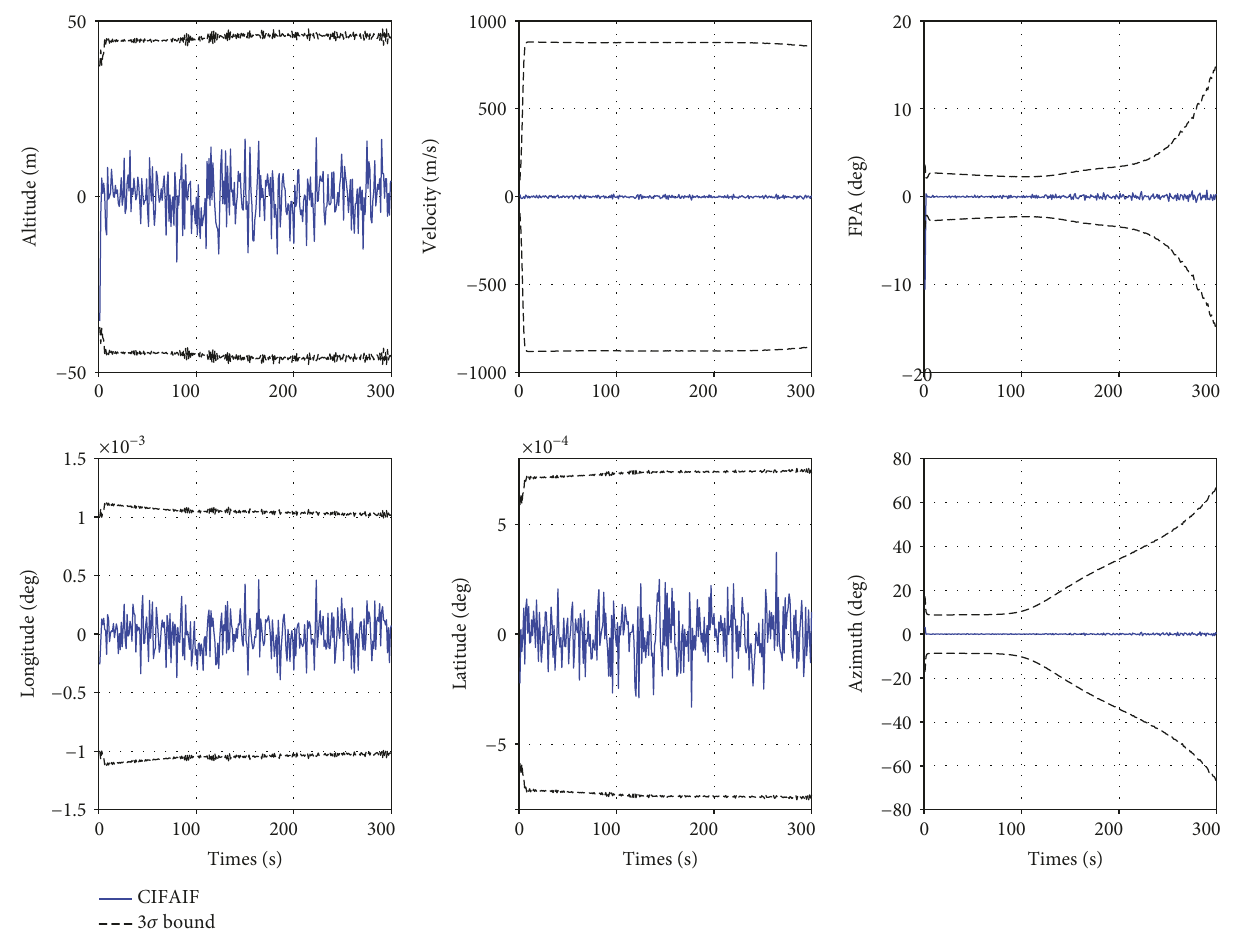
Figure 6: State estimate errors and 3 σ bounds for DCIFAIF.